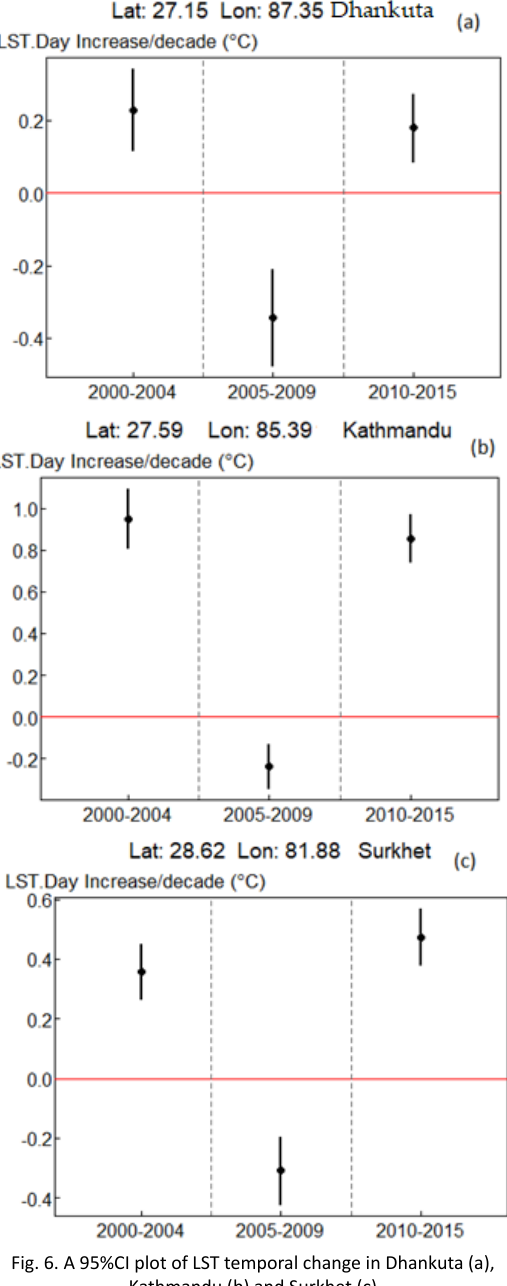
Fig. 6. A 95%CI plot of LST temporal change in Dhankuta (a), Kathmandu (b) and Surkhet